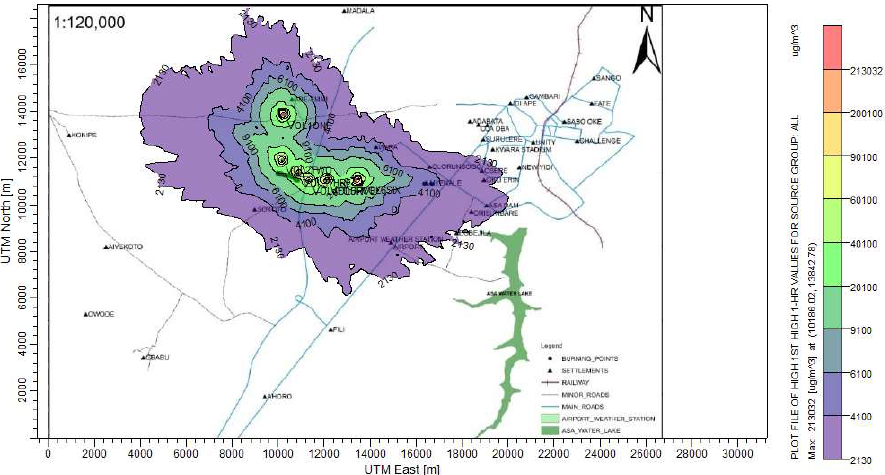
Figure 7. Isopleth of 1-h ground level NO x from Sokoto-Aiyekale dump site.